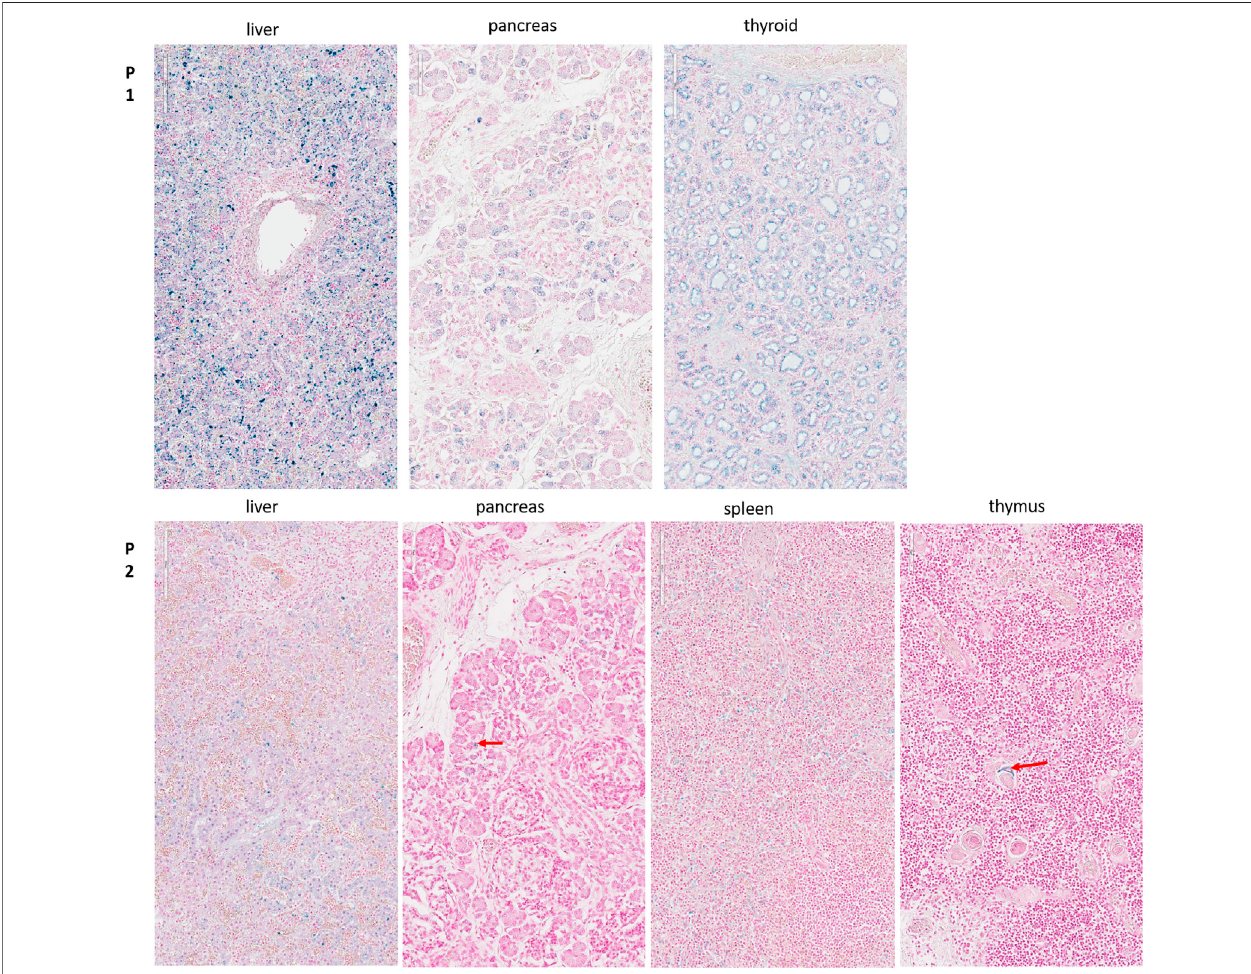
FIGURE 3 | Perls staining for the detection of hemosiderosis. Upper panel (P1): Diffuse hemosiderosis in liver parenchyma, thyroid follicles, and pancreatic acini of the fi rst child. Lower panel (P2): Liver: relatively diffuse hemosiderosis in liver parenchyma, less intense than in her brother; Pancreas: focal hemosiderosis in a few acini (arrow); Spleen: diffuse hemosiderosis in macrophages; Thymus: focal hemosiderosis in a few Hassal corpuscles